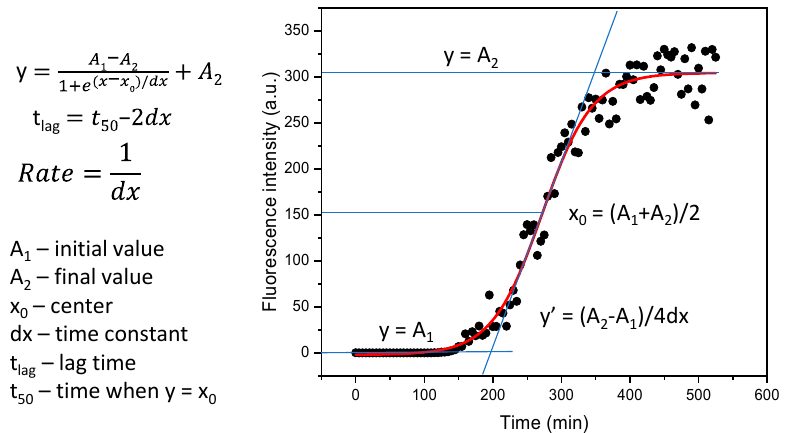
Figure A1. α -syn sample bound-ThT fluorescence intensity distribution at different ionic strength and protein concentra- tion conditions.